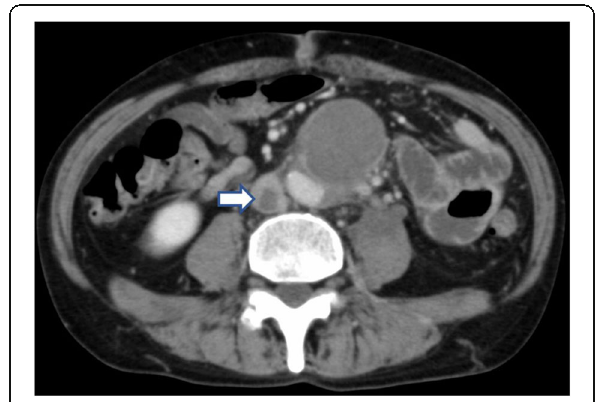
Fig. 2 Enhanced computed tomography at initial examination showing the 10 mm thrombus in the inferior vena cava (arrow)